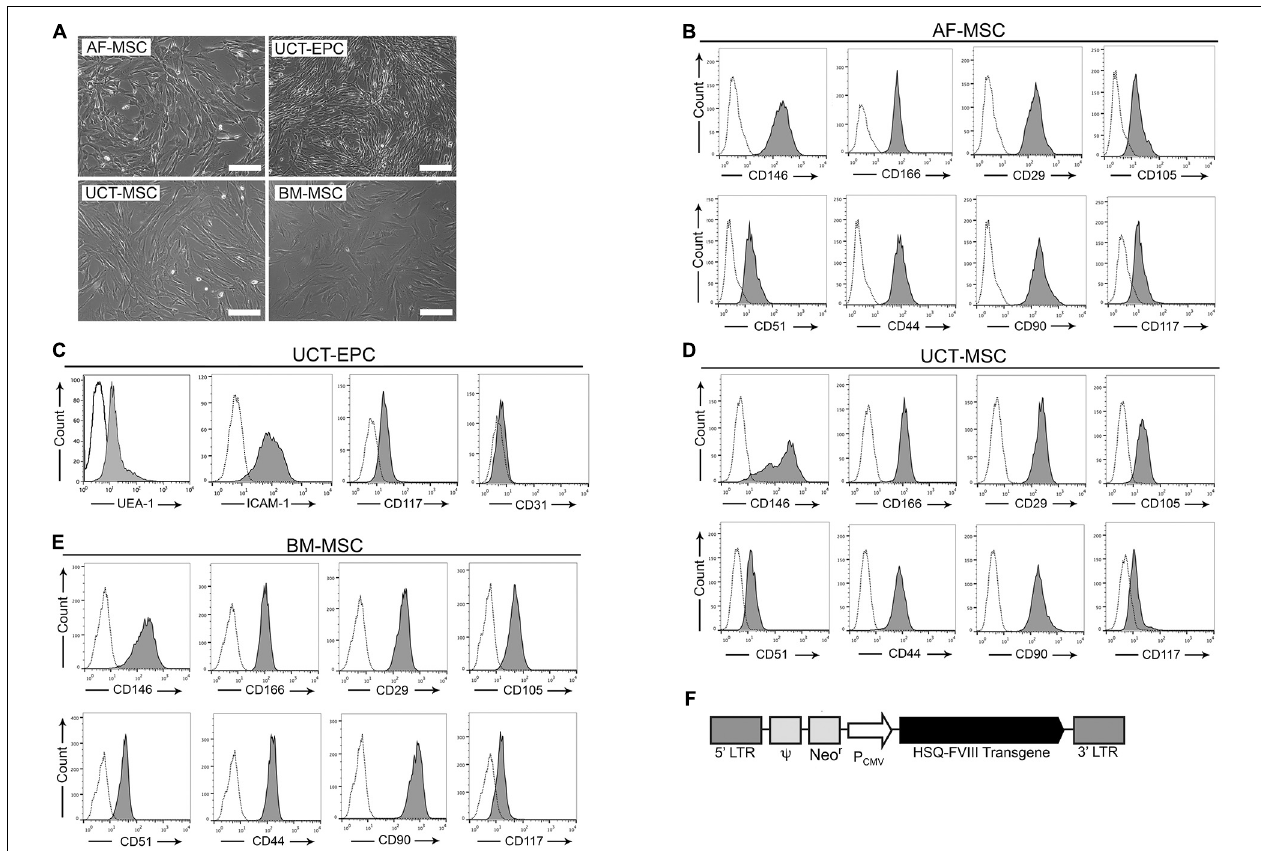
FIGURE 1 | Isolated cells were characterized via light microscopy and flow cytometry. (A) Cells visualized microscopically all had spindle-shaped morphology. Scale bar = 200 µ m. Flow cytometric analysis was performed on isolated: (B) amniotic fluid-derived mesenchymal stromal cells (AF-MSC), (C) cord tissue-derived endothelial progenitor cells (UCT-EPC), (D) cord tissue-derived mesenchymal stromal cells (UCT-MSC), and (E) bone marrow-derived mesenchymal stromal cells (BM-MSC). (F) Schematic representation of the MMLV-based vector encoding the B domain-deleted human fVIII transgene (HSQ) under the control of the CMV